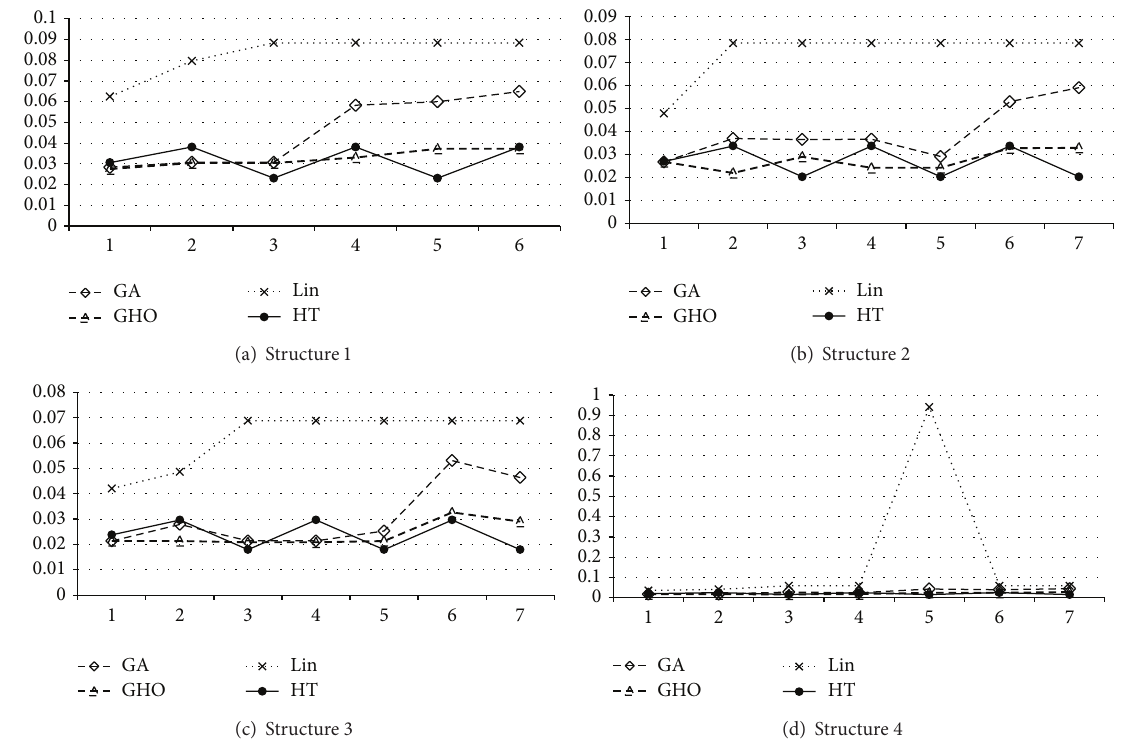
Figure 5: Energy consumption of embedded JPEG encoding